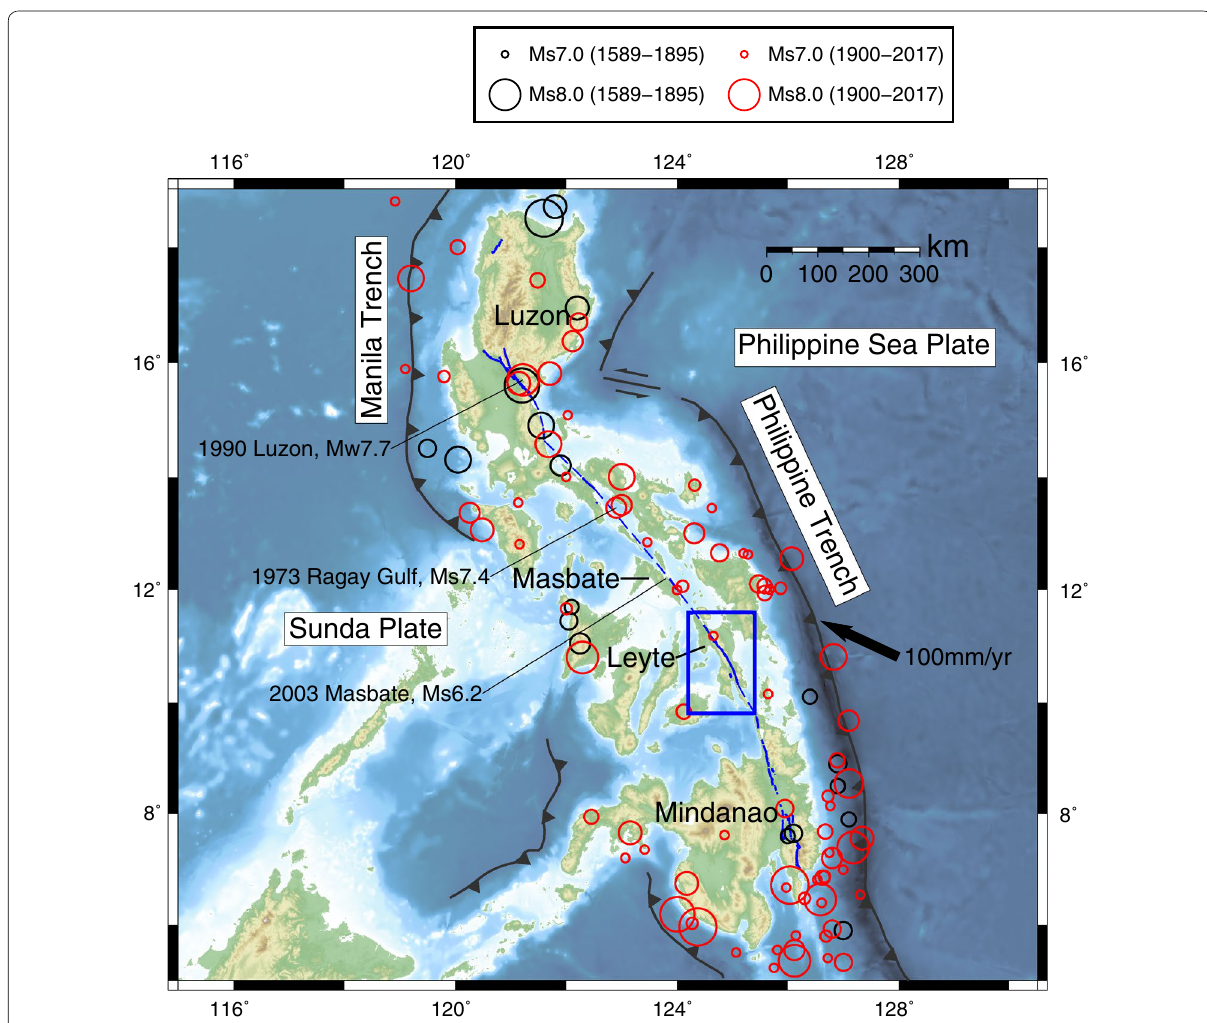
Fig. 1 Tectonic setting, historical large earthquakes in the Philippines, and the study area (blue rectangle). Historical earthquake locations are from Bautista and Oike (2000) (black circles) and ISC catalogs (Di Giacomo et al. 2018, red circles). Blue solid and dashed lines are the Philippine fault traces mapped by Tsutsumi and Perez (2013) and inferred fault locations,